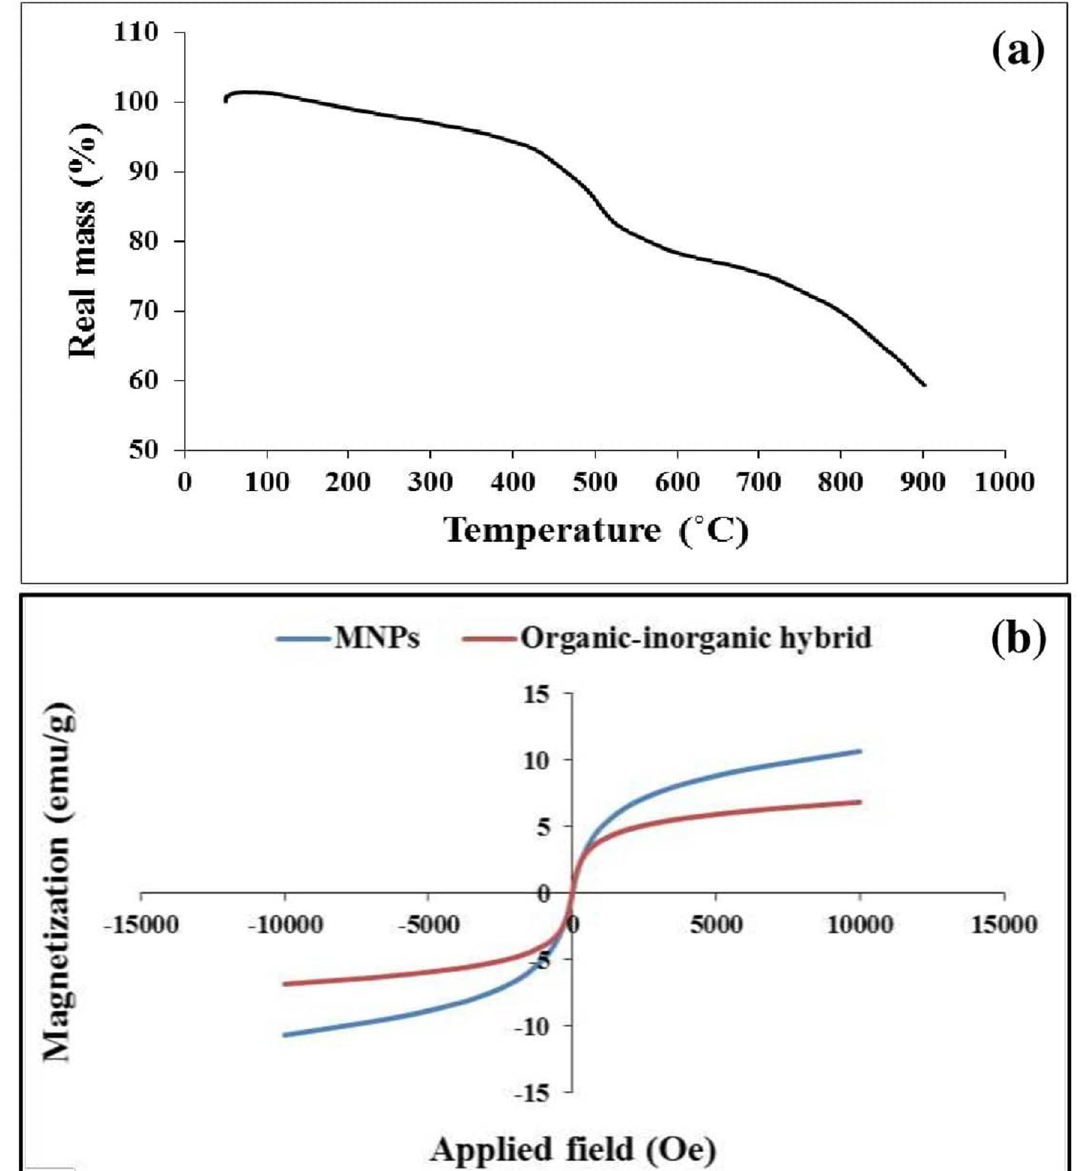
Figure 6. ( a ) Thermogravimetric curve of prepared hybrid by 1,4-phenylenediamine and terephthaloyl chloride on the magnetic ZnFe 2 O 4 and ( b ) Hysteresis loop curve of prepared hybrid by 1,4-phenylenediamine and terephthaloyl chloride on the magnetic ZnFe 2 O 4